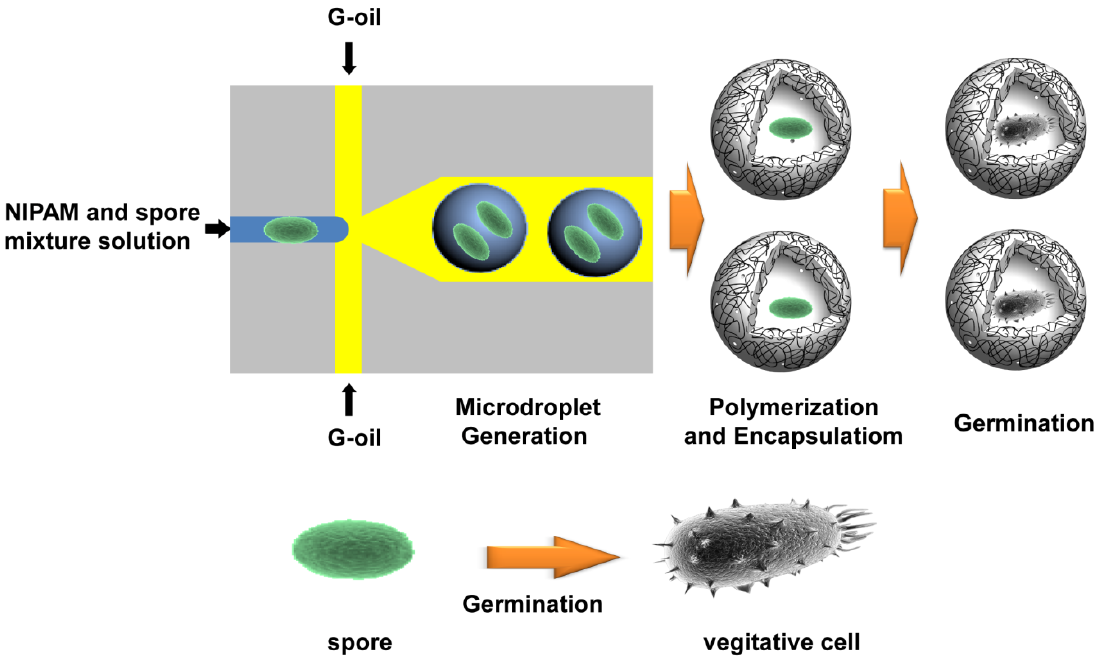
Figure 1. Schematic illustration of the BT spore-encapsulation process and the germination of BT spores in the